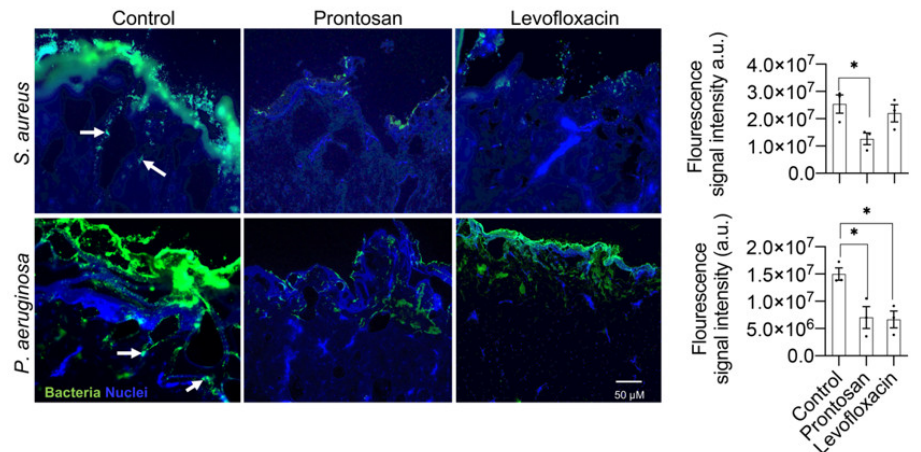
Figure 7. Immunofluorescence visualization of S. aureus and P. aeruginosa in infected wounds. Wounds were infected with S. aureus or P. aeruginosa , incubated for two hours, and treated with the antimicrobial agents Prontosan or 2 µg/mL Levofloxacin. After 2 h of treatment, the wound tissue was embedded and frozen in OCT for cryosectioning. Cryosections were then stained with the rabbit-anti-staphylococcus aureus IgG or rabbit-anti-pseudomonas IgG primary antibodies. An alexa-fluor-568-labeled goat-anti-rabbit IgG was used as secondary antibody. To visualize nuclei (blue), sections were counterstained with DAPI. Representative images are shown ( n = 3). Arrow shows bacterial invasion in the tissue. Fluorescence intensity was measured as integrated density of the fluorescence signal and represented as arbitrary units (a.u.). Data are presented as Mean ± SEM ( n = 3). Significant results are denoted as * p <